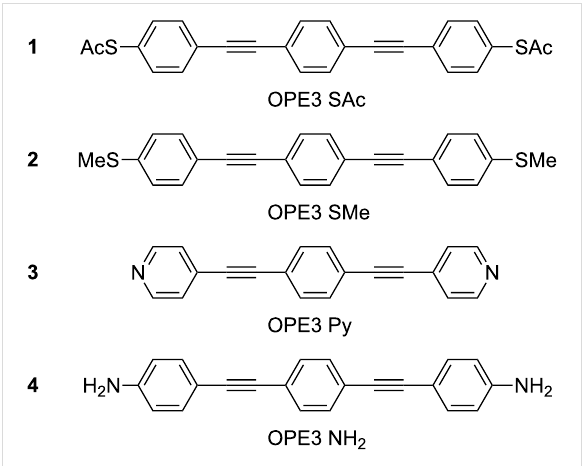
Figure 1: Chemical structures of the molecules studied in this